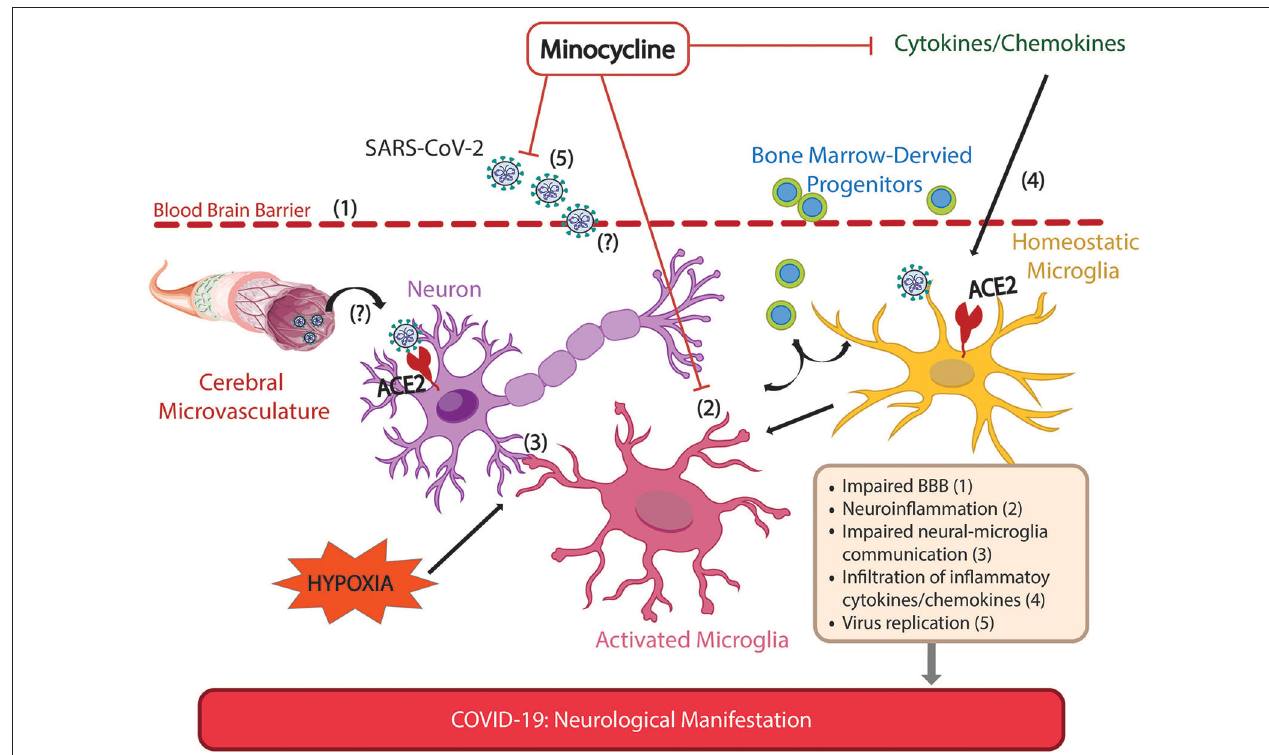
FIGURE 1 | Possible sites of action of minocycline for alleviation of neurological manifestations of Covid-19. Neurological manifestations have been extensively reported in COVID-19 patients, and are associated with more severe symptoms. These manifestations may arise by direct and/or indirect mechanisms following SARS-CoV-2 infection. The SARS-CoV-2 receptor, ACE2, is expressed in neurons, glial and endothelial cells allowing the virus to infect and spread in the brain, impairing cellular communication. SARS-CoV-2 virus has been demonstrated in brain parenchyma and possible routes for SARS-CoV-2 infiltration such as impaired blood brain barrier are shown. Anosmia, a common sign of SARS-CoV-2 infection reflecting olfactory nerve damage, may illustrate another possible route of virus infiltration, via peripheral nerves to the CNS. Indirect effects on CNS include those from Covid-19-induced hypoxia such as neuroinflammation, impaired neuron-microglia communication, autonomic imbalance, impaired BBB, increased inflammatory cytokines and increased release of BM-derived progenitor cells. This is consistent with experiments in rodents that directly investigated brain damage due to hypoxia. Minocycline, an anti-inflammatory antibiotic that readily penetrates the CNS, counteracts neuroinflammation, virus replication and attenuates the increase of pro-inflammatory cytokines. Together, these actions of minocycline alleviate hypoxia-induced neuroinflammation and impaired neural-microglial communication that may precipitate neuronal and glial injury, thus preventing potential long-term neurological consequences of